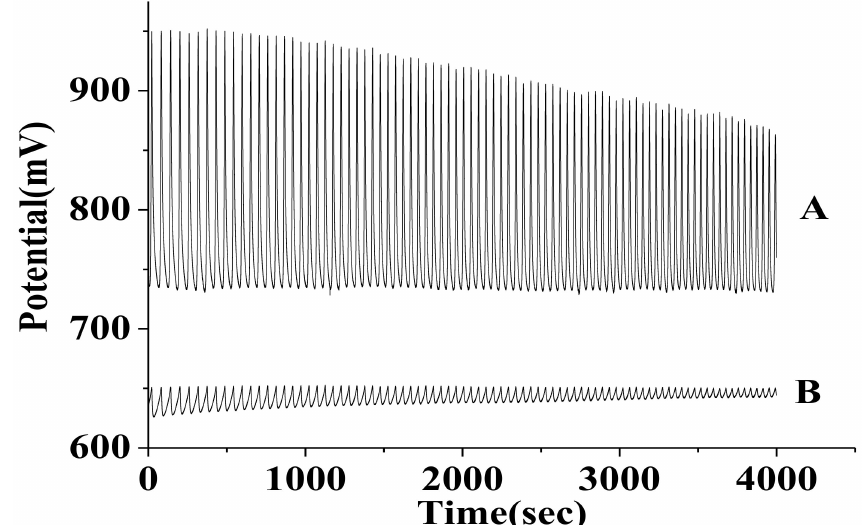
Figure 2. Typical potential oscillation profiles in the absence of light (voltage-time): ( A ) platinum electrode, ( B ) bromide ion selective electrode. Common conditions: [H 2 SO 4 ] 0 = 1.05 mol/L; [Acetone] 0 = 0.65 mol/L;[Glucose] 0 = 0.06 mol/L;[Sodium bromate] 0 = 0.08 mol/L; [[Cu](ClO 4 ) 2 ] 0 = 0.05